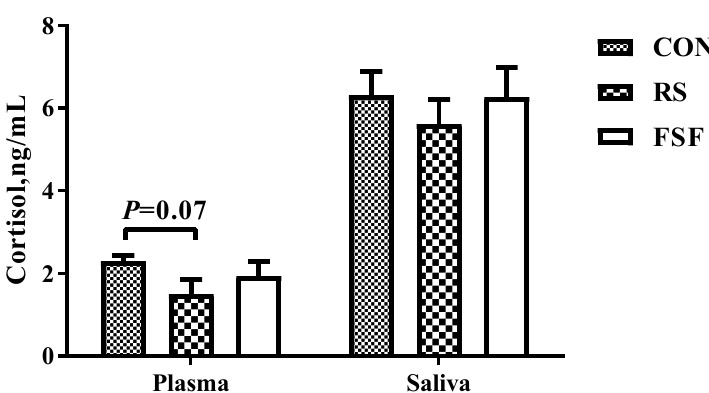
Figure 3. Effect of inclusion of resistant starch (RS) or fermented soybean fiber (FSF) in gestation diet on sows’ plasma and saliva cortisol concentration on day 70 of gestation. CON = control diet group; RS = 5% resistant starch diet group; FSF = 5% fermented soybean fiber diet group. Values are means ± SEM ( n = 7–8).